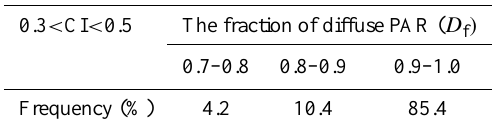
Table 1. Frequency distribution of the fraction of diffuse PAR ( D f ) for 0.3 < CI < 0.5.